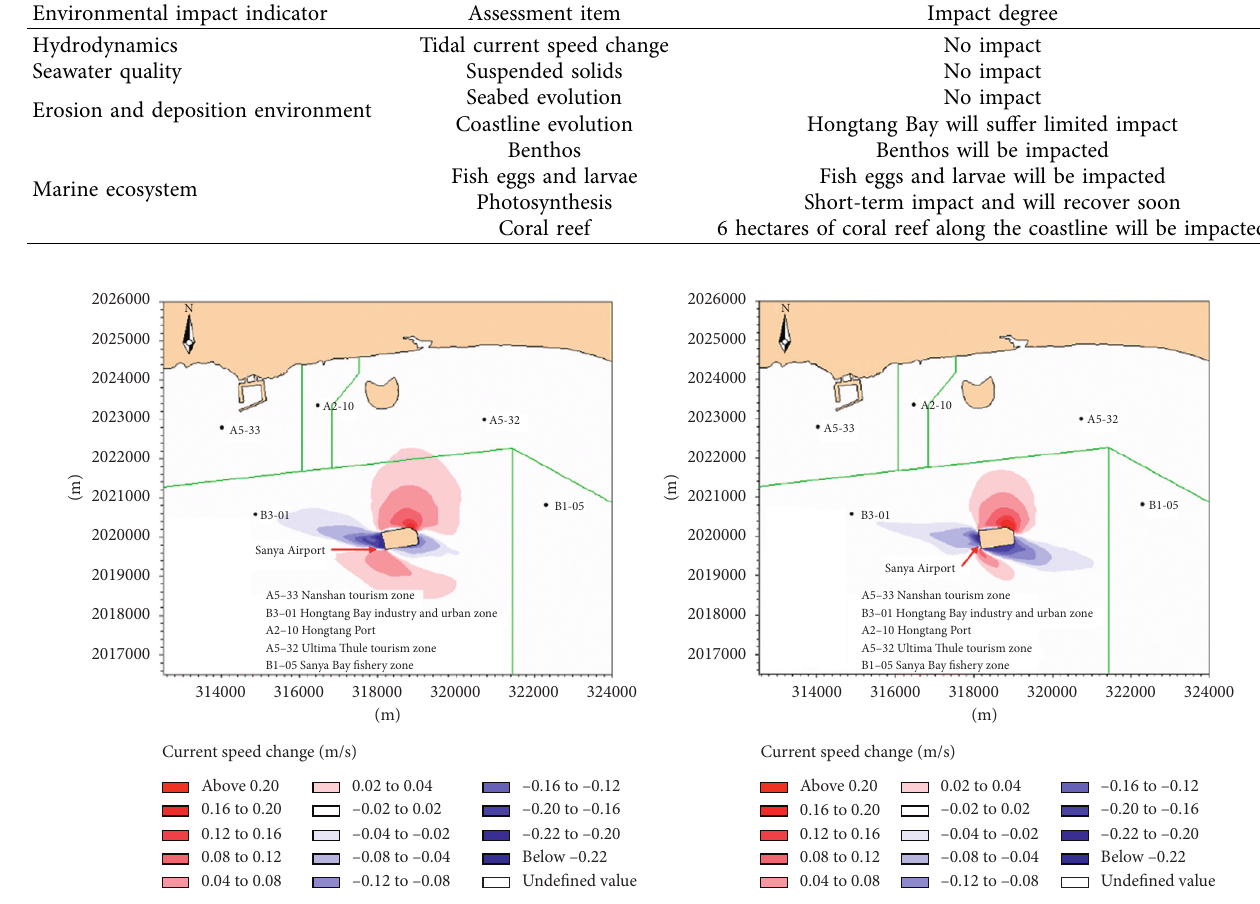
Table 1: SSRA environmental impact assessment.